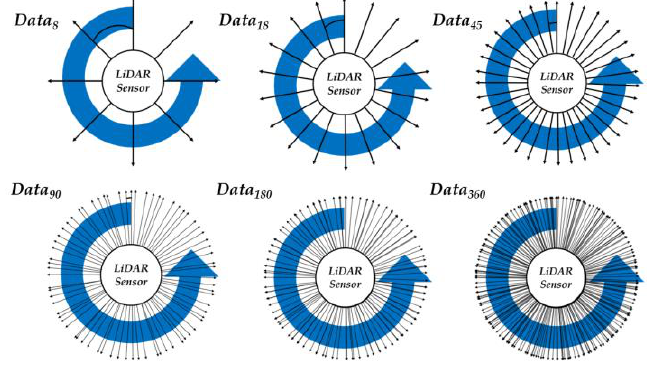
Figure 3. Data Density of Six Learning Models.